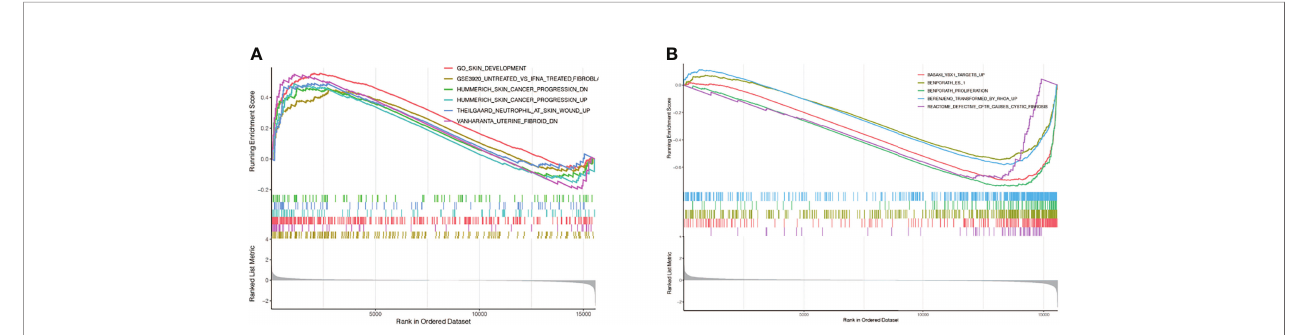
FIGURE 9 | GSEA enrichment analysis. (A) In the group with high expression of TNC in keloids, the enrichment pathways included skin development, fi broblast, cancer progression, neutrophil at skin wound, and uterine fi broid; (B) In the low TNC expression group, the enriched pathways included YBX1 targets, ES-1, proliferation, transformed by RhoA, and defetive CFTR cause cystic fi